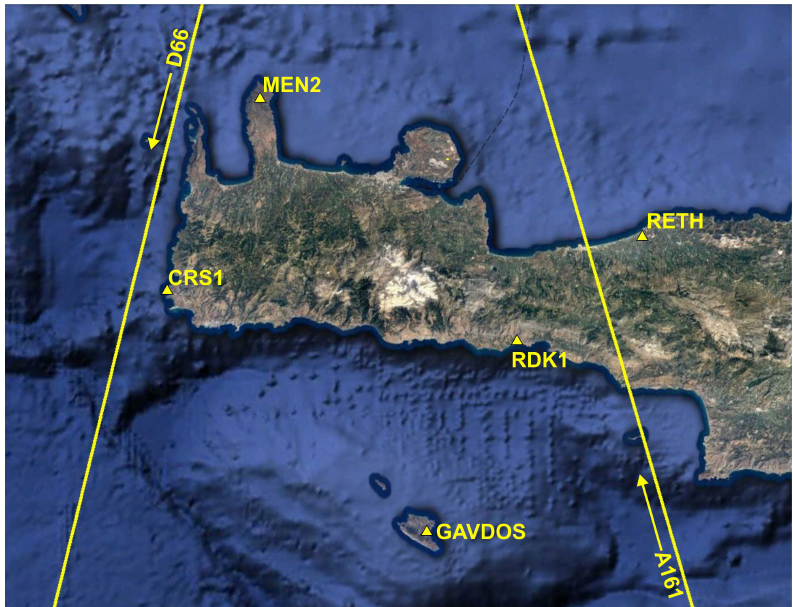
Figure 11. The ascending and descending ground tracks of the HY-2B satellite altimeter over Crete and Gavdos. The locations of the Cal/Val sites (i.e., CRS1, RDK1 and Gavdos) and the permanent GNSS sites (i.e., MEN2 and RETH) used for the HY-2B